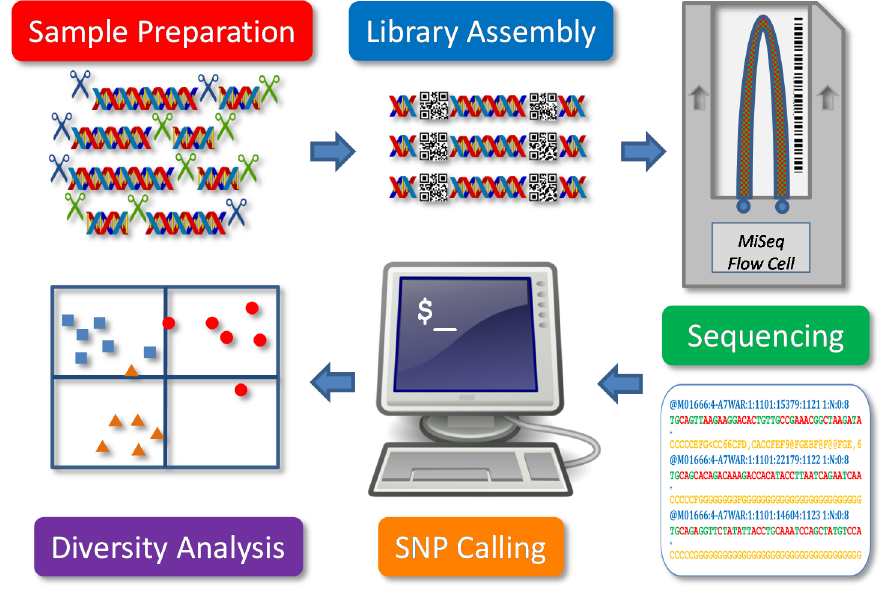
Figure 1. Schematic presentation of a genotype-by-sequencing application for plant genetic diversity analysis. Five components are illustrated.